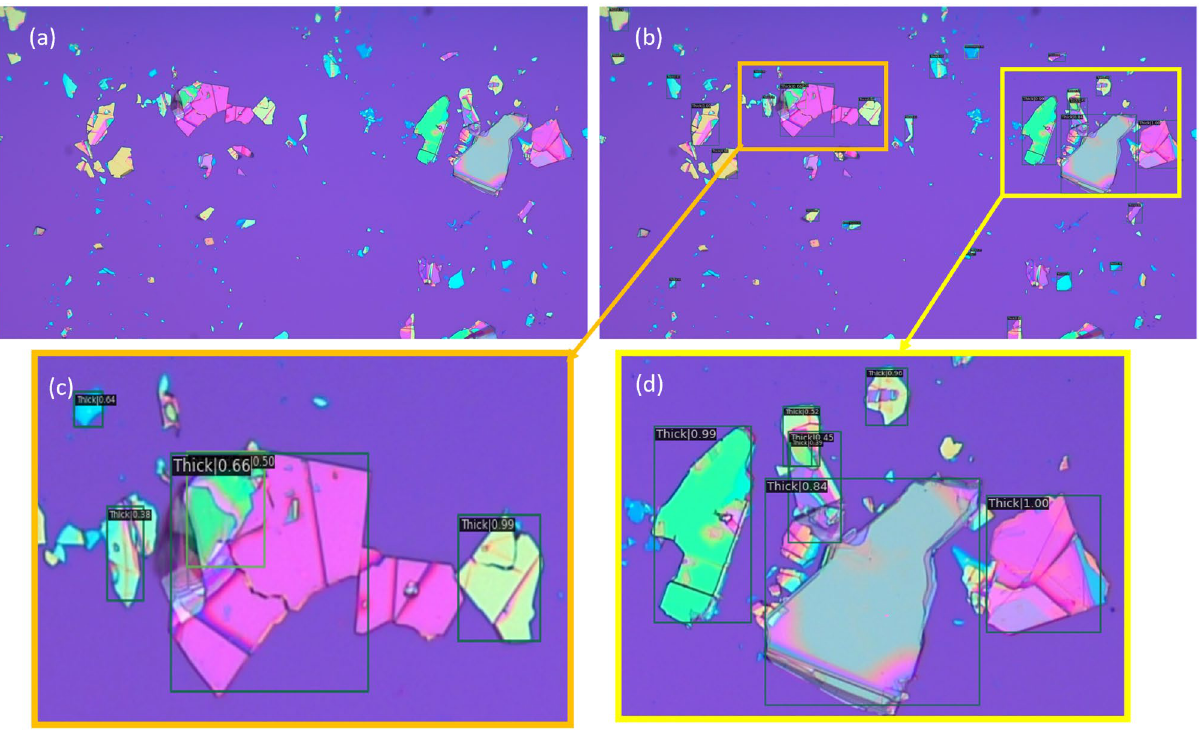
Figure 6. Results obtained from using the proposed algorithm on one image from the UA dataset; Part ( a ) shows the raw image, part ( b ) shows the labels generated by the algorithm, and parts ( c ) and ( d ) are zoomed-in regions showing the flake type and confidence score reported by the algorithm. We manually identified 32 flakes in the image, and the algorithm correctly classified 20 of them. (Microscope images obtained by Hugh Churchill and used with permission.).